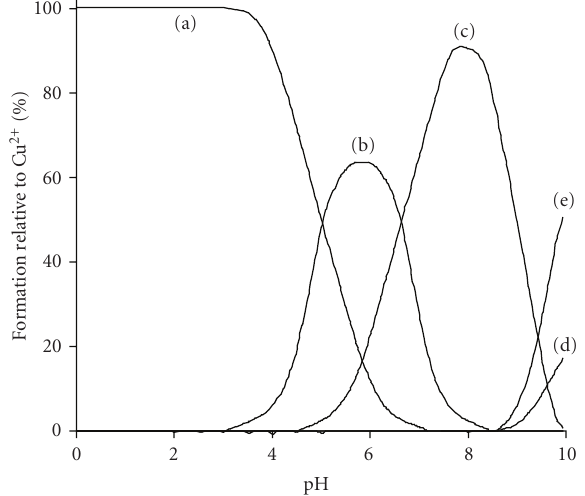
Figure 4: Species distribution (% formation relative to Cu 2+ ) in the Cu(II)-H 6 bicah system with metal-to-ligand molar ratio 1:2 concentration (H 6 bicah 5.00 mmoldm − 3 ) as a function of pH over the range 2.00–10.0 (25 ◦ C, I = 0 . 10 moldm − 3 KCl, pK w = 13 . 78, and γ = 0 . 78). The Cu(II) species are